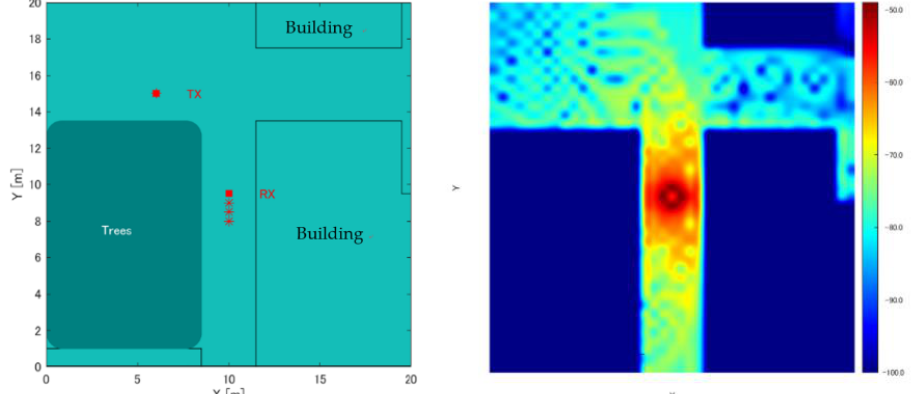
Figure 3. Examples of RSSI MAP generation. ( left ) 2D model including surrounding building information. ( right ) RSSIMAP based on Rx (colors represent strength of RSSI value).